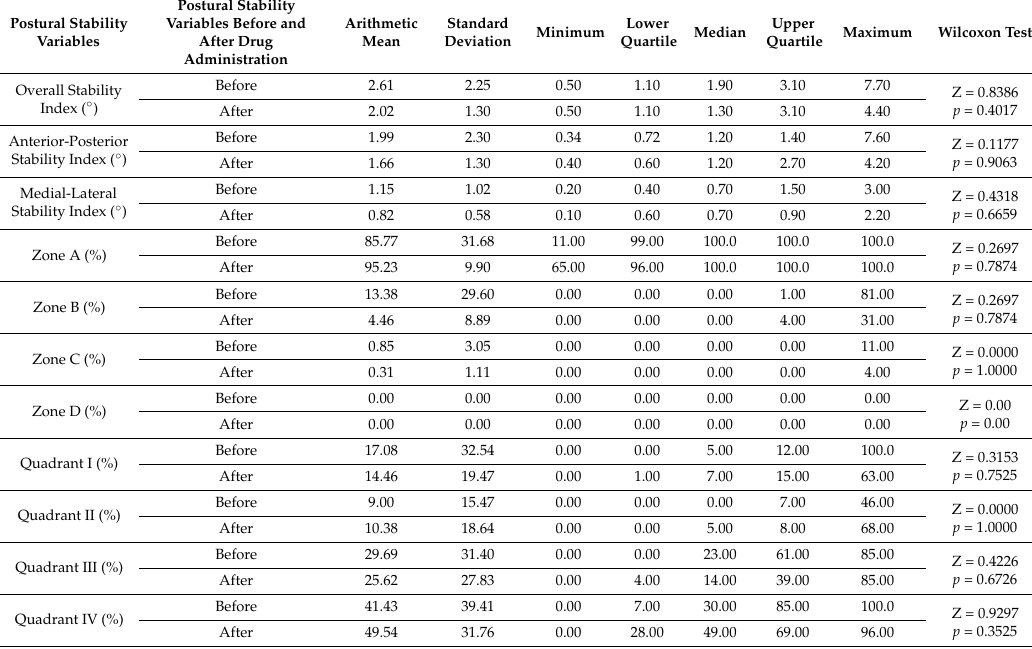
Table 4. Postural stability before and after L-dopa